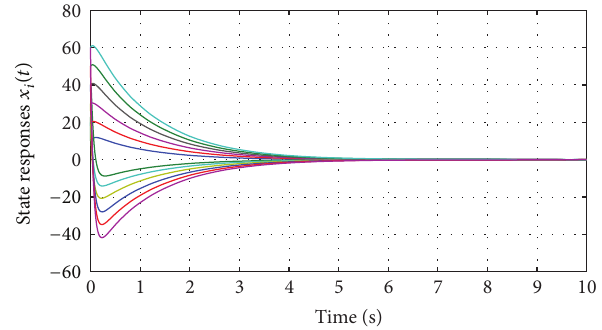
Figure 2: The state trajectories of six agents with topology G 1 .